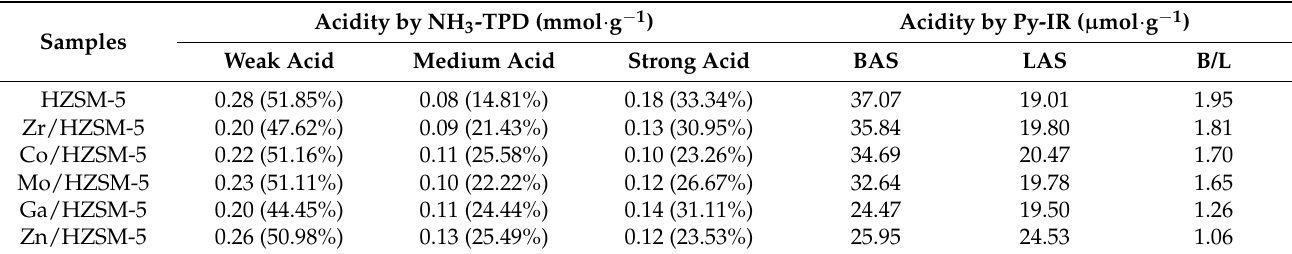
Table 2. Acidic properties of the